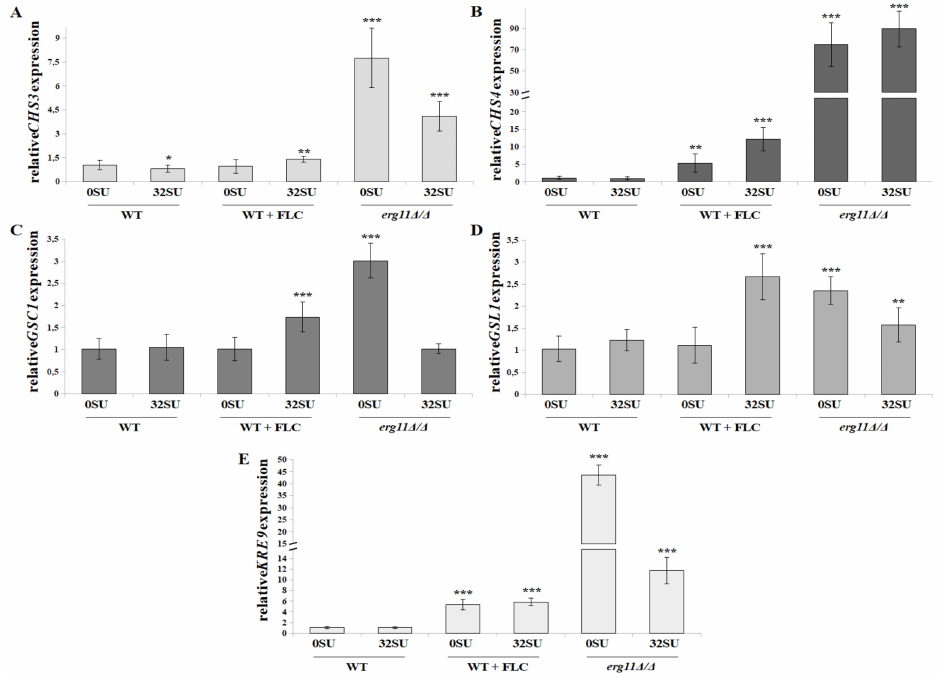
Figure 6. Relative CHS3 ( A ), CHS4 ( B ), GSC1 ( C ), GSL1 ( D ) or KRE9 ( E ) gene expression in C .